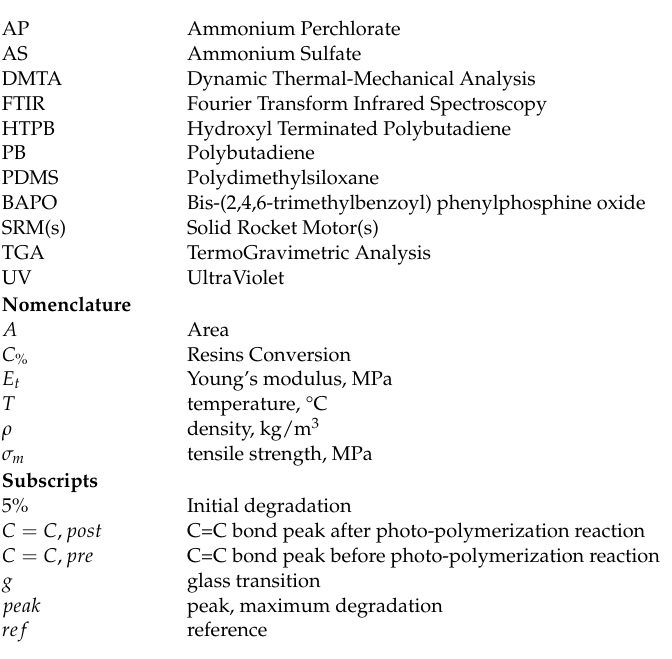
TGA graphs of BisAEtDA formulations; Figure S3c: TGA graphs of HexaDA formulation; Figure S3d: TGA graphs of PEGDA formulations; Figure S3e: TGA graphs of TEGORAD formulations; Figure S3f: TGA graphs of PB